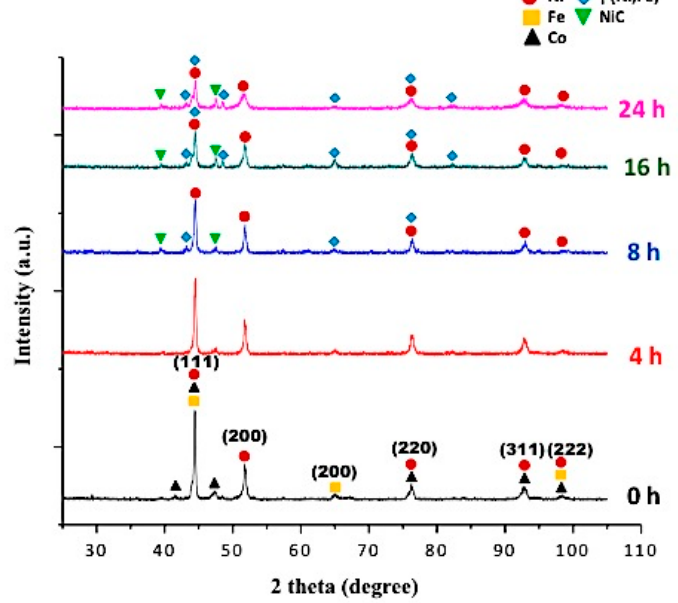
Figure 1. X-ray diffraction (XRD) spectra of the Ni-Fe-Co powders milled for 0 h, 4 h, 8 h, 16 h, and 24 h.